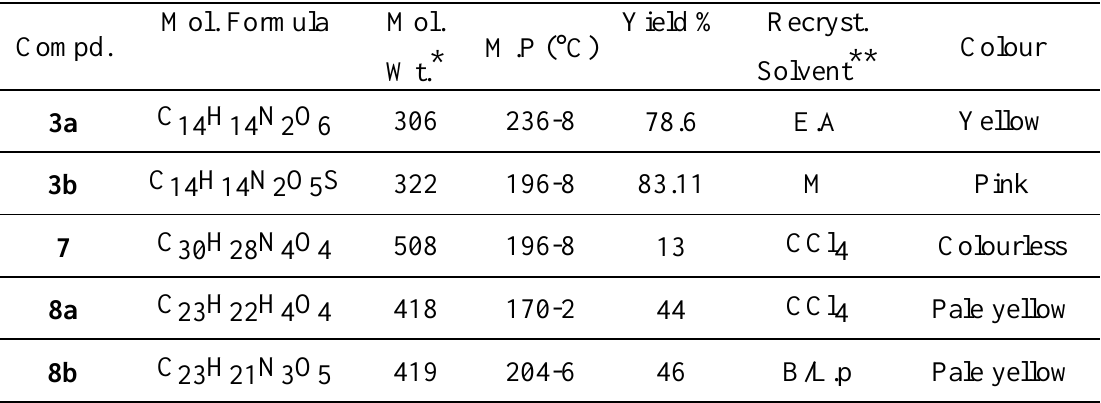
Table 1. Physical characteristics of the new